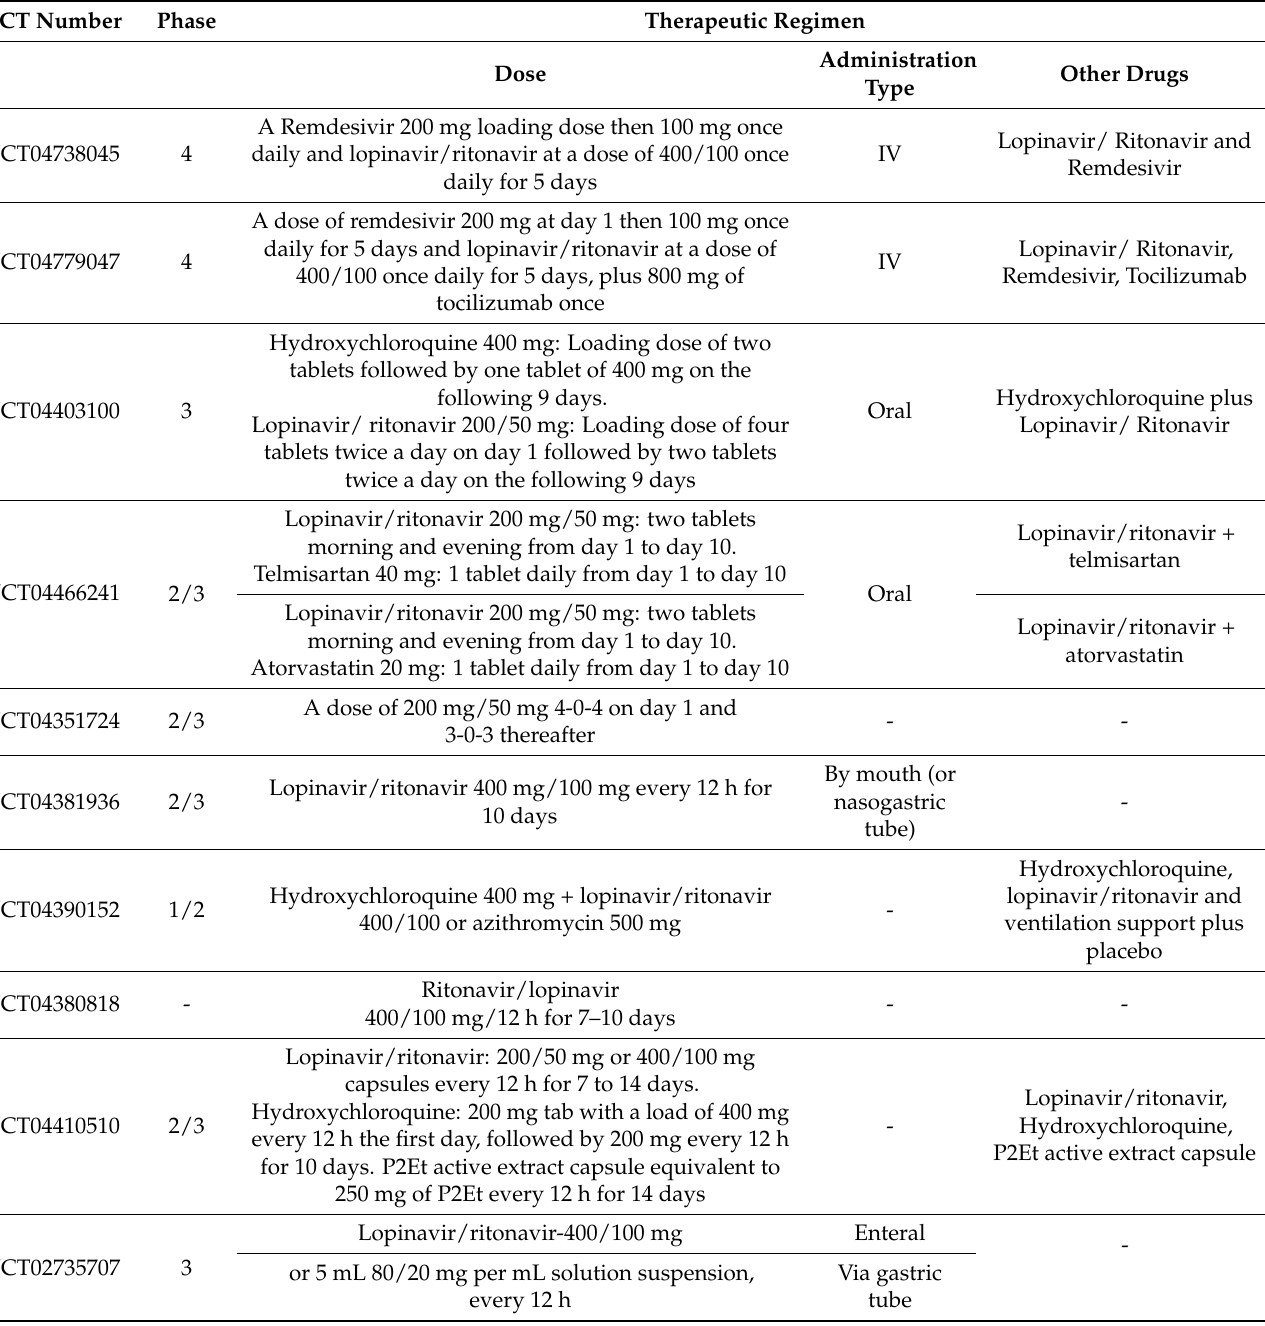
Table 7. Clinical trials using lopinavir and ritonavir for the treatment of COVID-19. Data was collected from clinicaltrials.gov on 28 November 2022. Inclusion criteria: Recruiting, adult population,